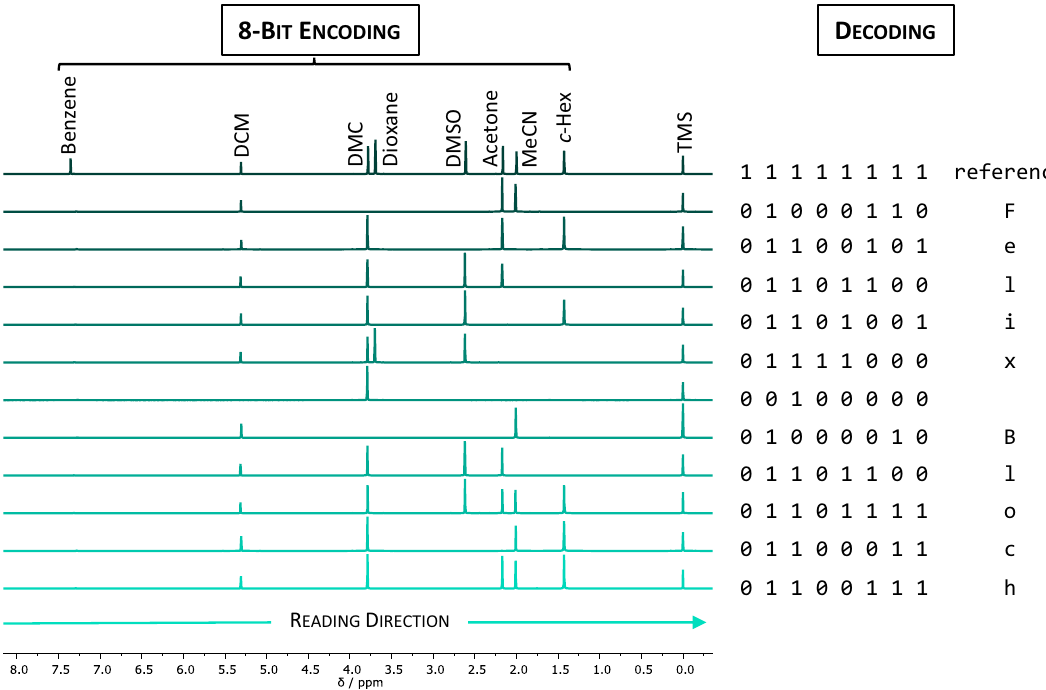
Figure 1. Encoding and decoding by 1 H NMR analysis. “Felix ␣ Bloch”, who was awarded the Nobel Prize together with Edward Mills Purcell (Supplementary Fig. 1) in 1952 70,71 , was encoded and decoded in mixtures of up to eight information-containing compounds via an 8-bit ASCII code. The reading direction was specified from low to high field and the ordering via manual placement in the sample holder. The absence or presence of a compound signal in the spectra was retranslated to a sequences of “0”s and “1”s to reconstruct the binary